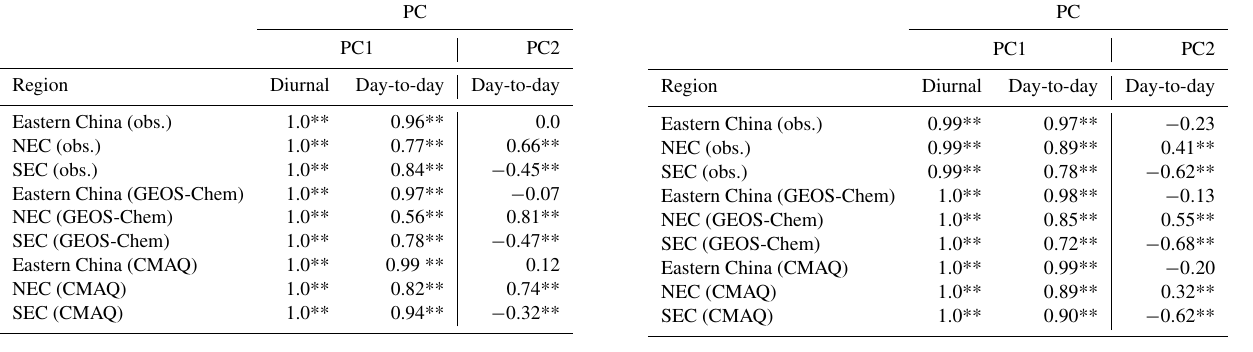
Table 2. Correlation between PCs and regional mean values in Table 1. Correlation between PCs and regional mean values in terms of diurnal and day-to-day variability for PM 2 . 5 terms of diurnal and day-to-day variability for NO 2 . PC PC1 PC2 Region Diurnal Day-to-day Day-to-day Eastern China (obs.)